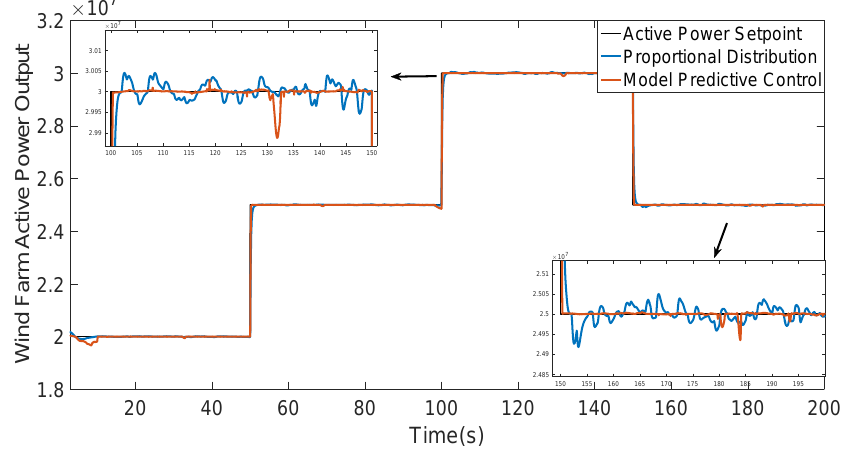
Figure 16. Wind farm active power output.